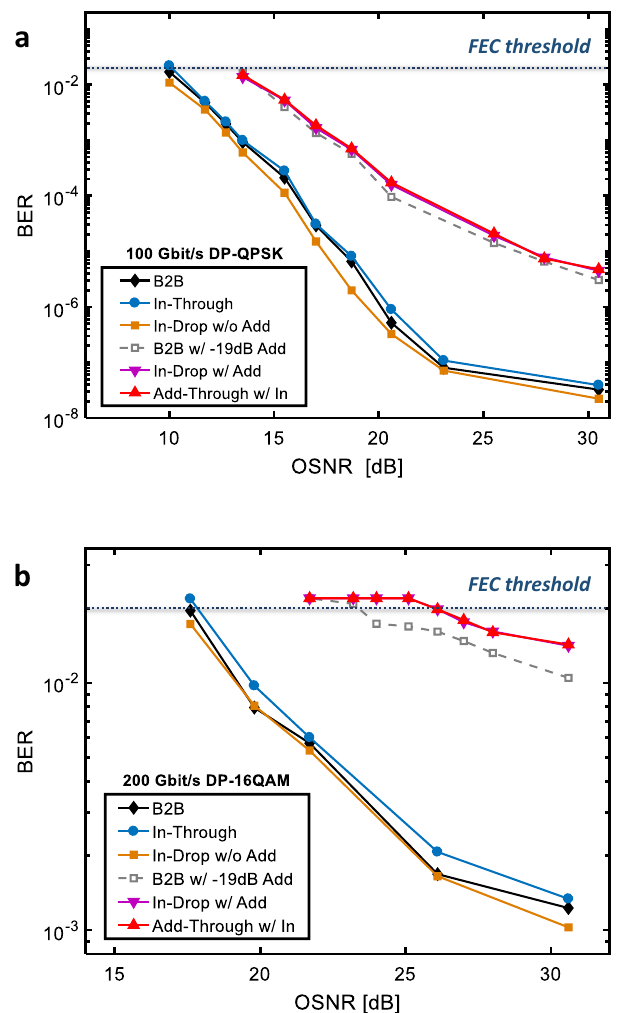
Fig. 4 Assessment of data transmission quality. Pre-FEC BER versus OSNR of ( a ) 100 Gbit/s DP QPSK channel and ( b ) 200 Gbit/s DP- 16QAM channel measured in the operating conditions speci fi ed in the legends. The OSNR is evaluated as the ratio between the optical signal power and the noise measured over a band of 0.1 nm close to the signal spectrum. Port naming refers to the polarization independent fi lter of Fig. 3a. BERs below the indicated FEC threshold are corrected in real time to an error-free condition by the FEC embedded in the receiver. In all the BER measurements, the polarization state of the light at the input of the fi lter is scrambled in sub-millisecond time